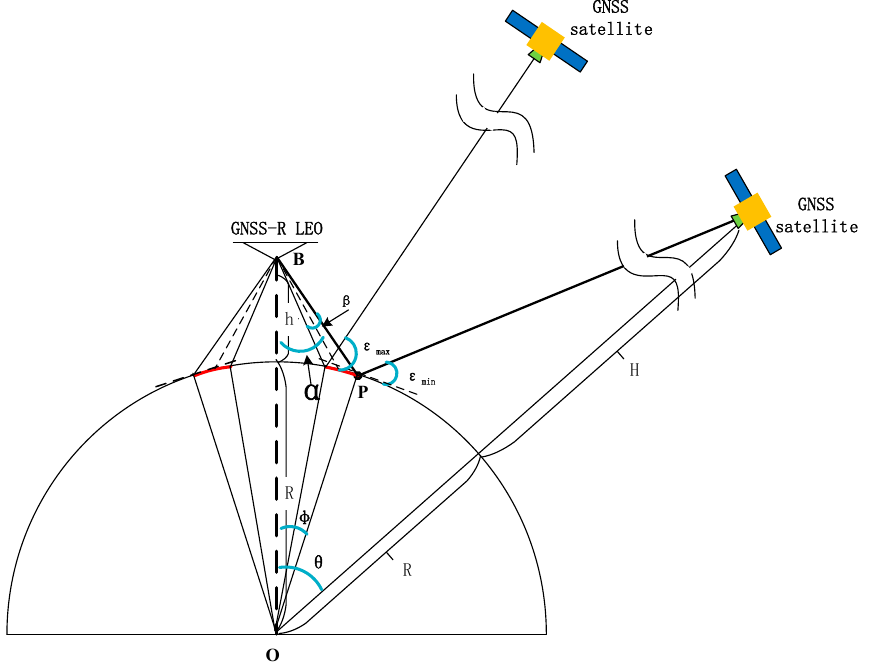
Figure 4. Geometrical relationships among the angles in the GNSS-R system. Here, in order to show the angles clearly, only two GNSS satellites and one GNSS-R LEO satellite are given in this figure.